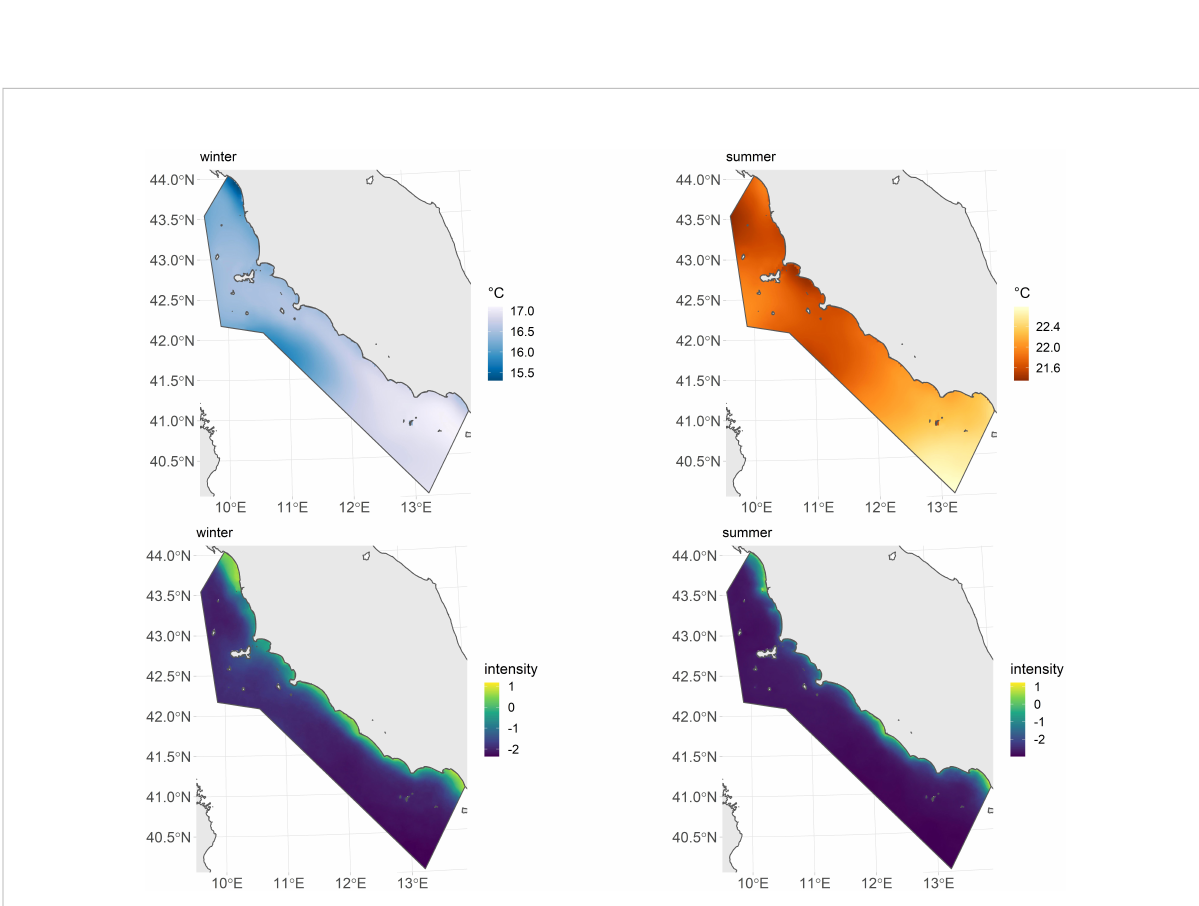
FIGURE 4 Sea surface temperature (SST) distribution in winter (upper left panel) and summer (upper right panel), and chlorophyll – a log – scale values in winter (lower left panel) and summer (lower right panel) in the study